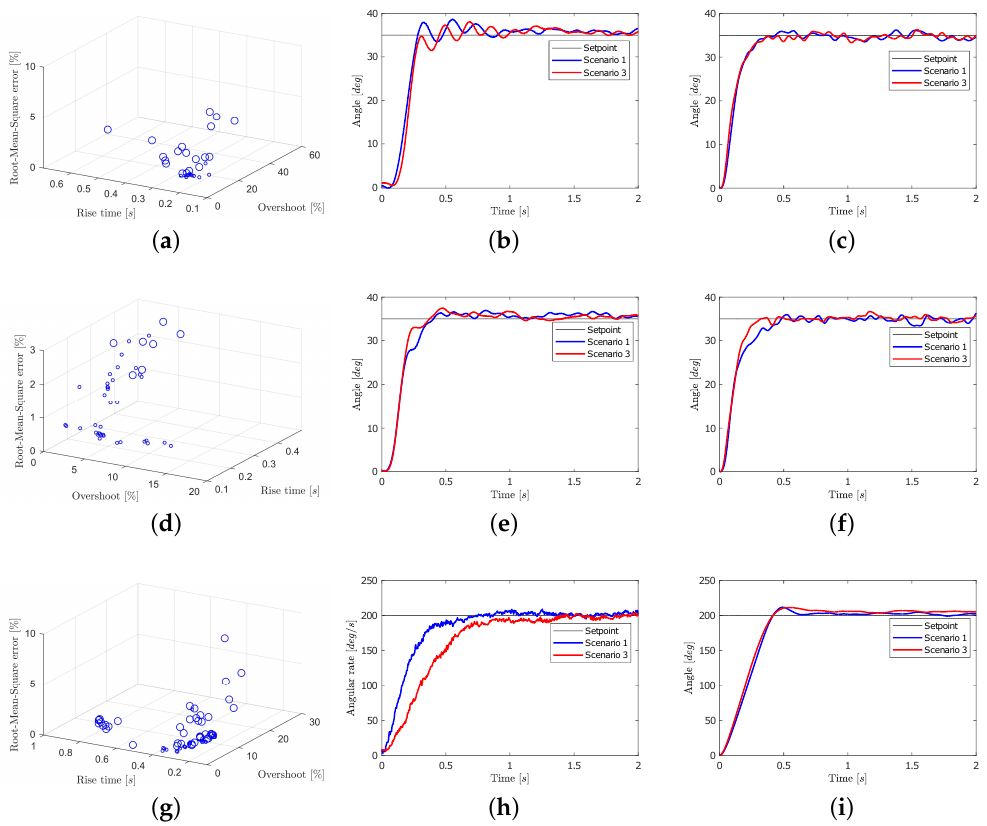
Figure 14. ( a ) Pareto front roll. ( b ) Roll axis response test. ( c ) Roll axis response simulation. ( d ) Pareto front pitch. ( e ) Pitch axis response test. ( f ) Pitch axis response simulation. ( g ) Pareto front yaw. ( h ) Yaw rate axis response test. ( i ) Yaw rate axis response simulation.